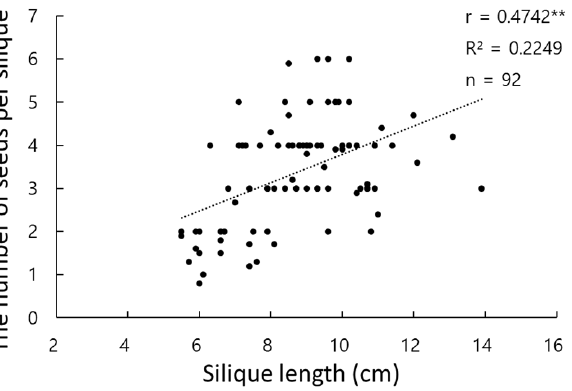
Figure 1. The distributions of silique length ( a ) and the number of seeds per silique ( b ) in radish among 92 F 2 individuals.